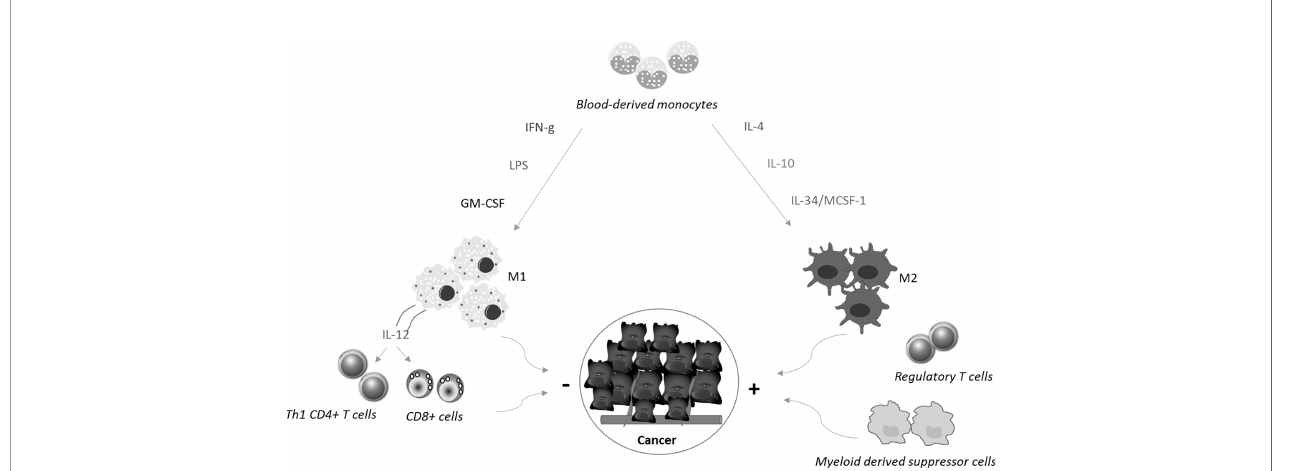
FIGURE 1 | Blood-derived monocytes are recruited to the tumor sites, where cytokines promote their polarization towards M1 or M2 macrophages. M1 macrophages are differentiated in response to the simulation with interferon- g (IFN − g ), Toll − like receptor ligands, such as lipopolysaccharide (LPS), or granulocyte − macrophage colony − stimulating factor. These cells produce interleukin (IL)-12, which in turn stimulates Th1 cell differentiation and activation of CD8+ T cells. Altogether these cell types limit cancer growth and diffusion. In contrast, together with regulatory T cells and myeloid-derived suppressor cells, M2 macrophages, which are differentiated in response to stimulation with IL − 4, IL − 10, and IL-34/MCSF-1, contribute to generate a microenvironment that sustains cancer cell